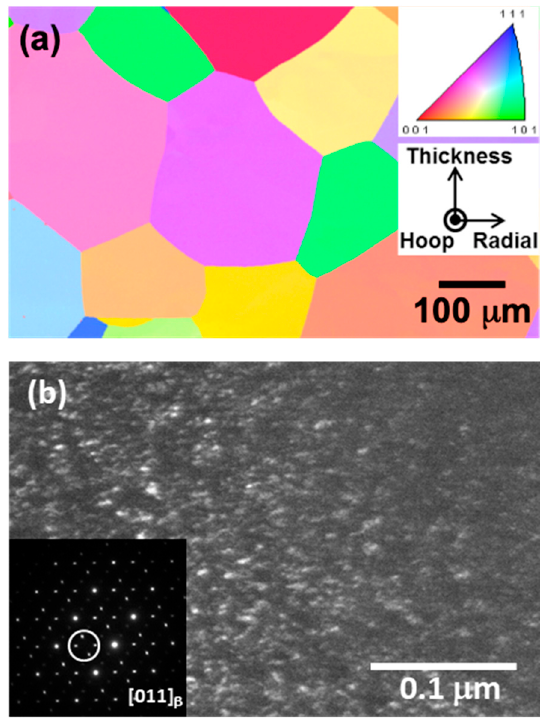
Figure 1. ( a ) EBSD inverse pole figure map of Ti-10Mo alloy after solution treatment, ( b ) dark field image of athermal ω phase and the corresponding SAED pattern along [011] β zone axis.